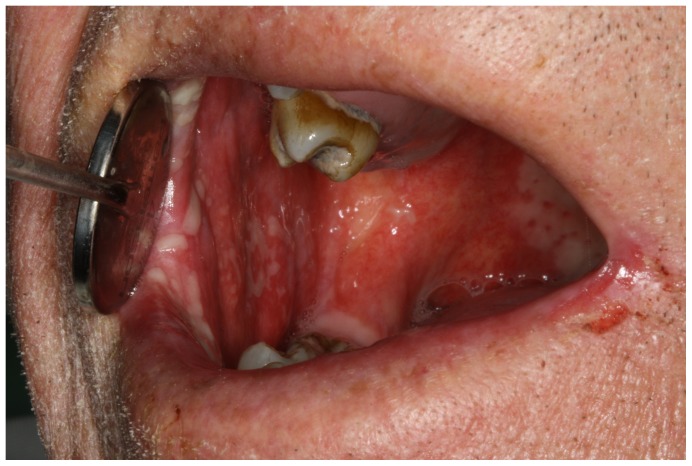
Oral mucositis is a side-effect of radiation treatment that leads to pain and limitations of mouth opening and numerous oral functions.